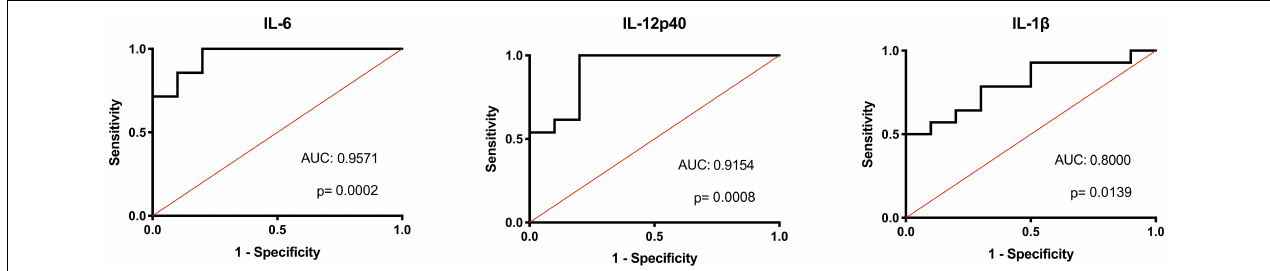
FIGURE 5 | Binary logistic regression with ROC curve output. Binary logistic regression with ROC curve output of the AFF group plotted against those in the NON-group. A receiver operating characteristic (ROC) curve analysis indicated that IL-IL-6, 12p40, and IL-1 β levels were significant predictors of affective psychoses (area under ROC curve, 0.9571, 0.9154, and 0.8000, respectively). The diagonal defines random